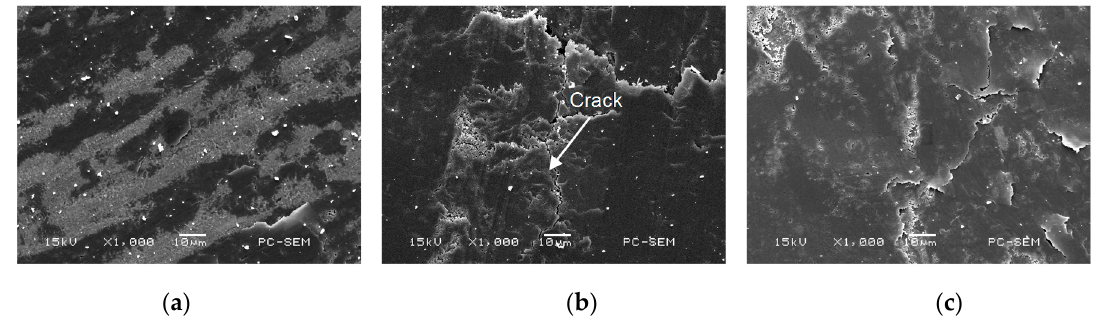
Figure 19. Morphologies of worn track on 17% Cr–83% Ni coating. ( a ) Adhesive wear; ( b ) Crack; ( c ) Spalling off.